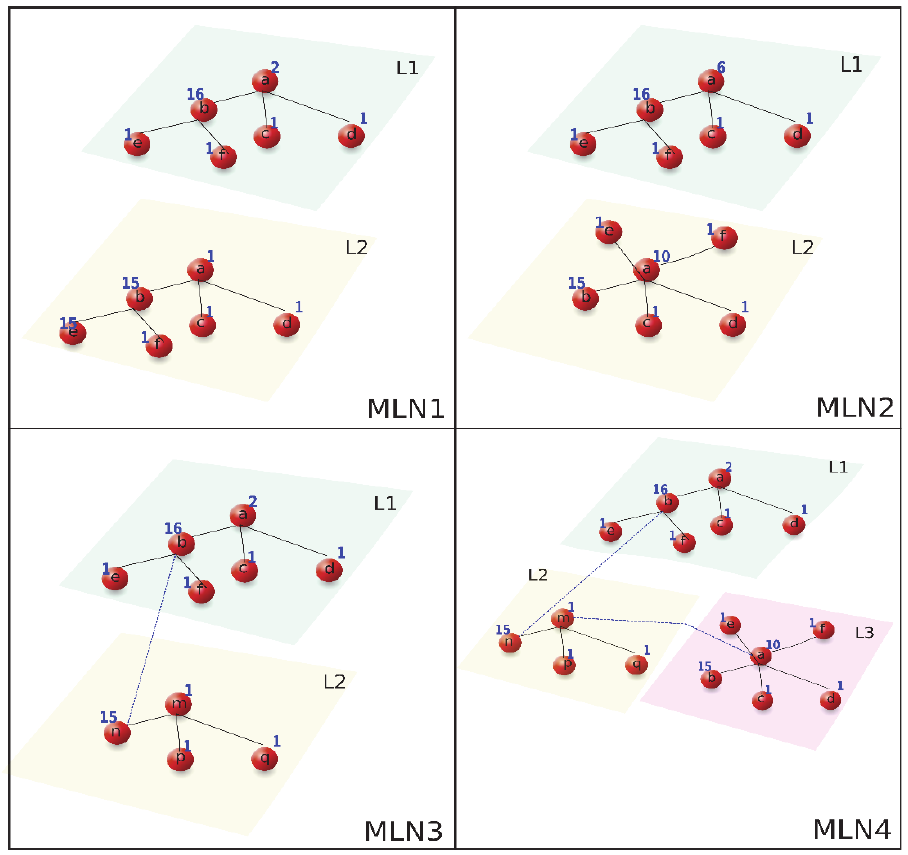
Figure 1. Examples of different multilayer networks. MLN1 is a multilayer network with two layers that have the same nodes and links. However, the nodes in each layer have different levels of importance. MLN2 has two layers with the same nodes but different links, and the nodes have different levels of importance. MLN3 has two layers with different nodes and links and the two layers are connected by links. MLN4 has three layers.